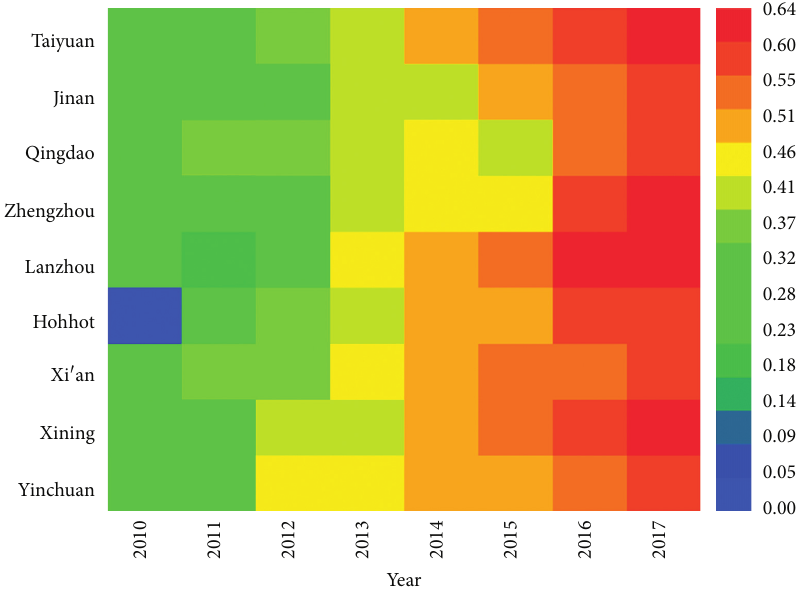
Figure 4: Coupling coordination of social economy and resources